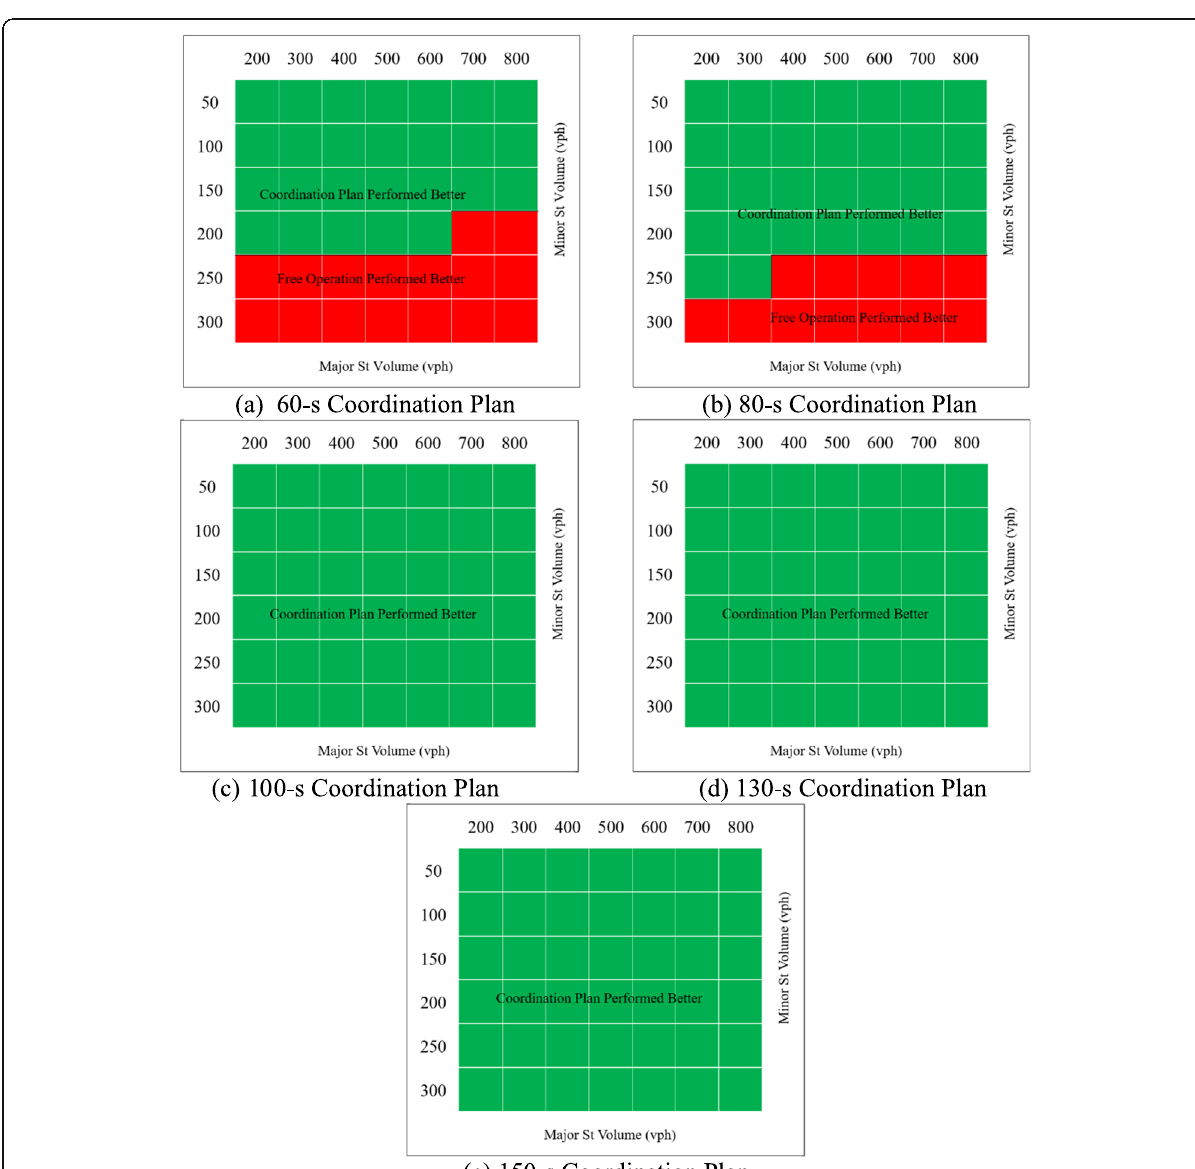
Fig. 7 Performance Comparison between Coordination Plans and Free Operation. a 60-s Coordination Plan. b 80-s Coordination Plan. c 100-s Coordination Plan. d 130-s Coordination Plan. e 150-s Coordination